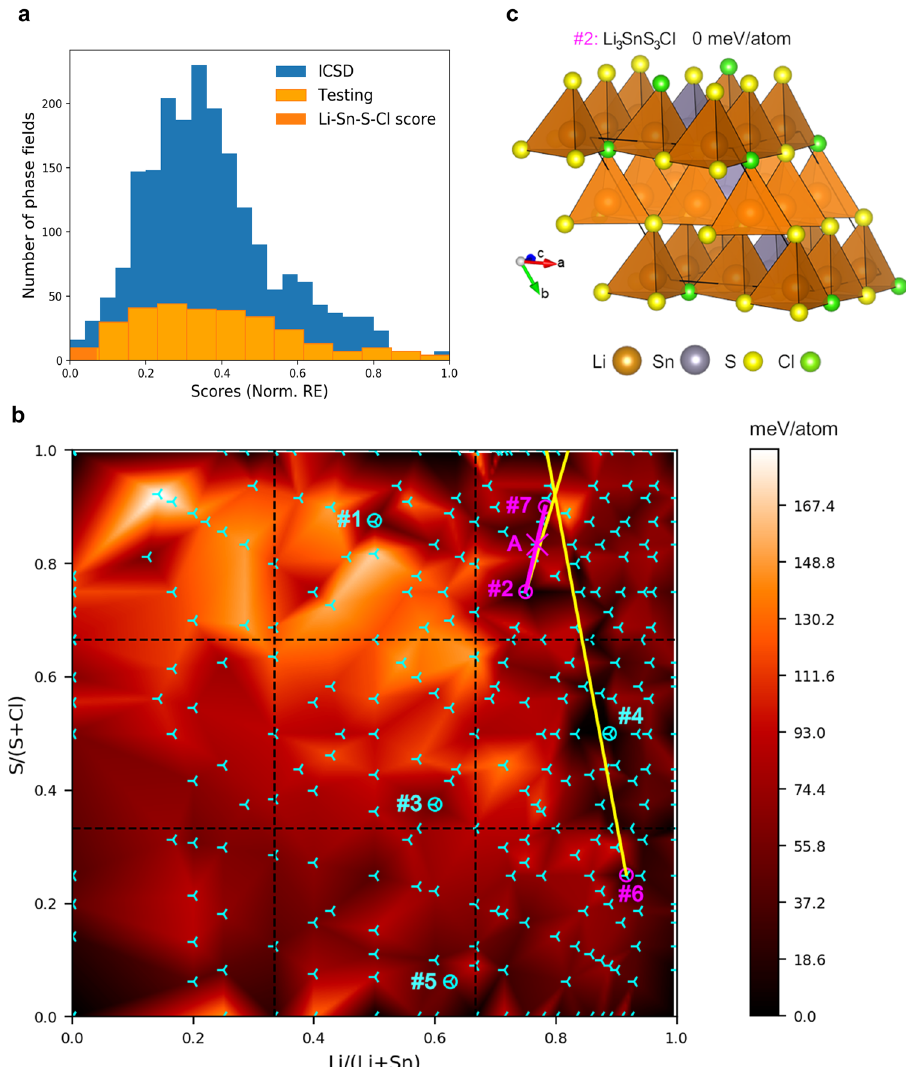
Fig. 2 Outcome of the phase- fi eld ranking method: from selection of elements to composition. a Distributions of the normalized reconstruction errors (scores) for training (ICSD-based, blue) and test (unexplored phase fi elds, orange) datasets, with the range of scores segmented according to 69 Supplementary Equation 1. The Li-Sn-S-Cl phase fi eld was chosen from the best-reconstructed candidates (dark orange). b Computational and experimental exploration of Li-Sn-S-Cl. Computed energies for 244 probe structures (cyan tripods) and interpolated formation energy above the convex hull 8 (color bar) guide the choice of compositions for experimental synthesis (circled tripods) (Supplementary Table 5). Samples #1 to #6: fi rst synthesis results. Cyan circles: formation of known compounds. Magenta circles: formation of Phase A (new phase) and known compounds (#2, #6). Phase A was identi fi ed by synthesizing sample #7 deduced from relative amounts of impurities in samples #2 and #6 (Supplementary Methods). Phase A (magenta cross) was then puri fi ed by targeting one composition on the Li 3.6 SnS 3.6 Cl 0.4 — Li 4 SnS 4 line (magenta line). c Predicted probe structure Li 3 SnS 3 Cl (#2)